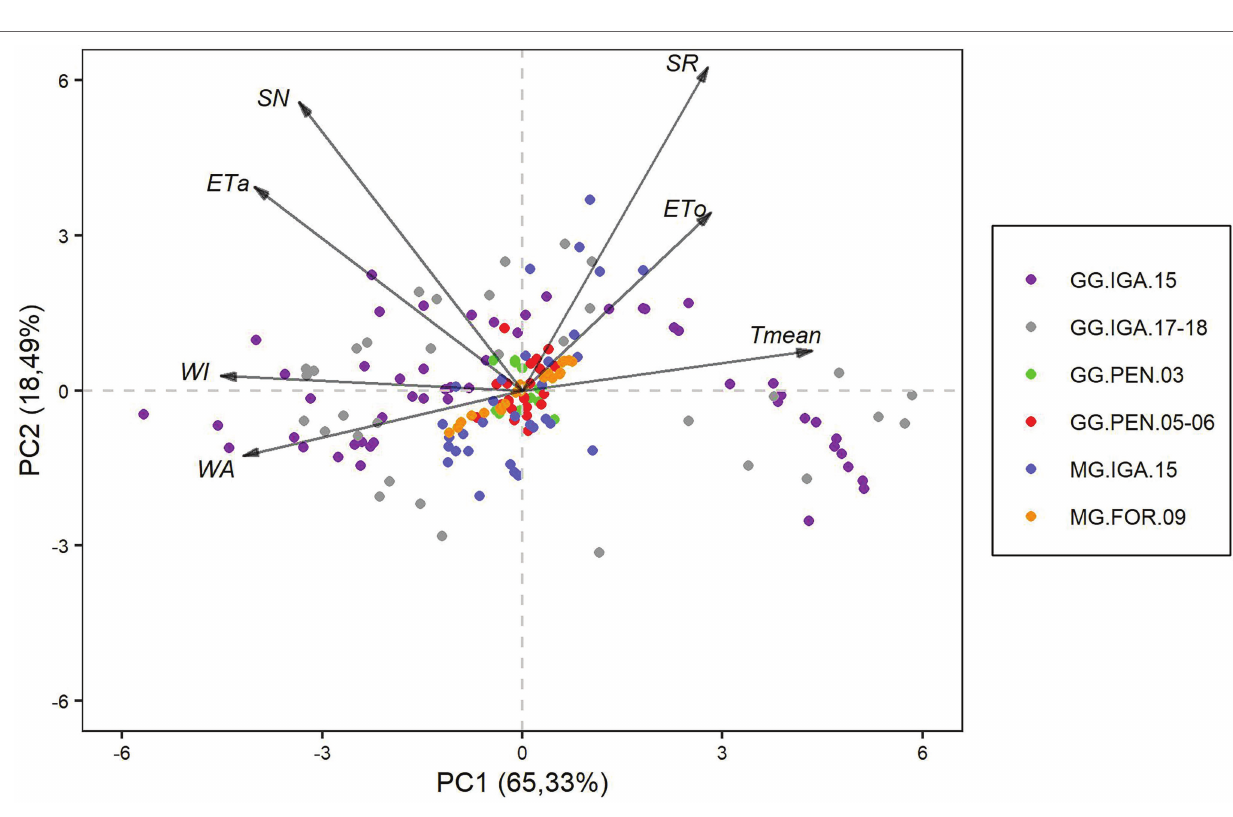
FIGURE 3 | Biplot representation of the first two main components obtained from the agrometeorological variables, with observations from the six types of trials with cultivars of the species Megathyrsus maximus . ETa, Actual Evapotranspiration; ETo, Reference Evapotranspiration; SN, Supplied nitrogen; SR, Solar radiation; Tmean, Mean temperature; WA, Water applied; and WI, Water